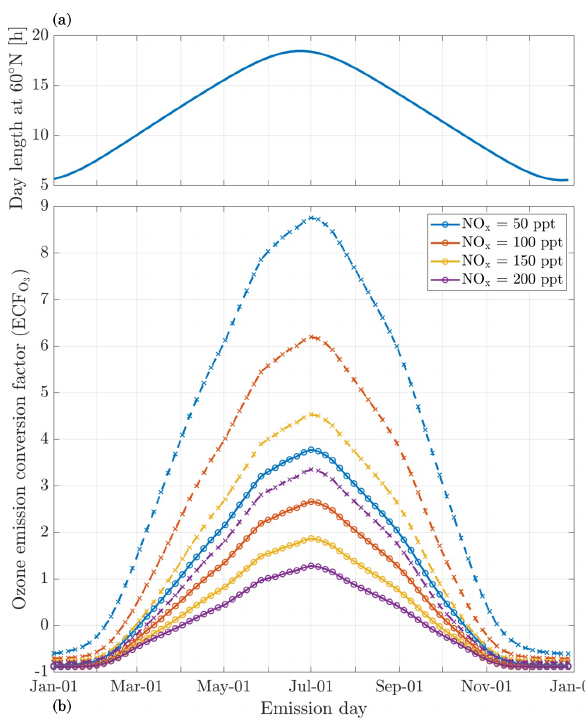
Figure 8. Panel (b) displays the 24h ozone emission conversion factor (ECF O ) from the emission of a B747-8 equipped with GEnx 3 engines at 08:00LT, at 60 ◦ N, for an instant-dilution approach (dot- ted lines) and the APCEMM plume model (continuous lines) as a function of day of the year. Different scenarios representing differ- ent background NO x mixing ratios are displayed. The cases corre- spond to a background O 3 mixing ratio of 52ppb. Panel (a) displays the amount of sunlight received at 60 ◦ N as a function of day of the year, expressed in hours of